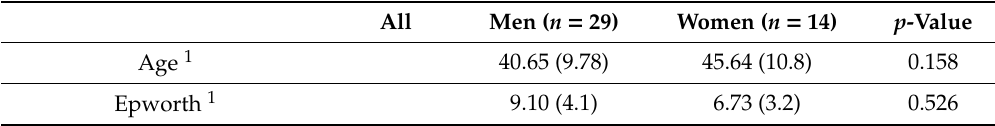
Table 4. Gender impact on analyzed variables 1